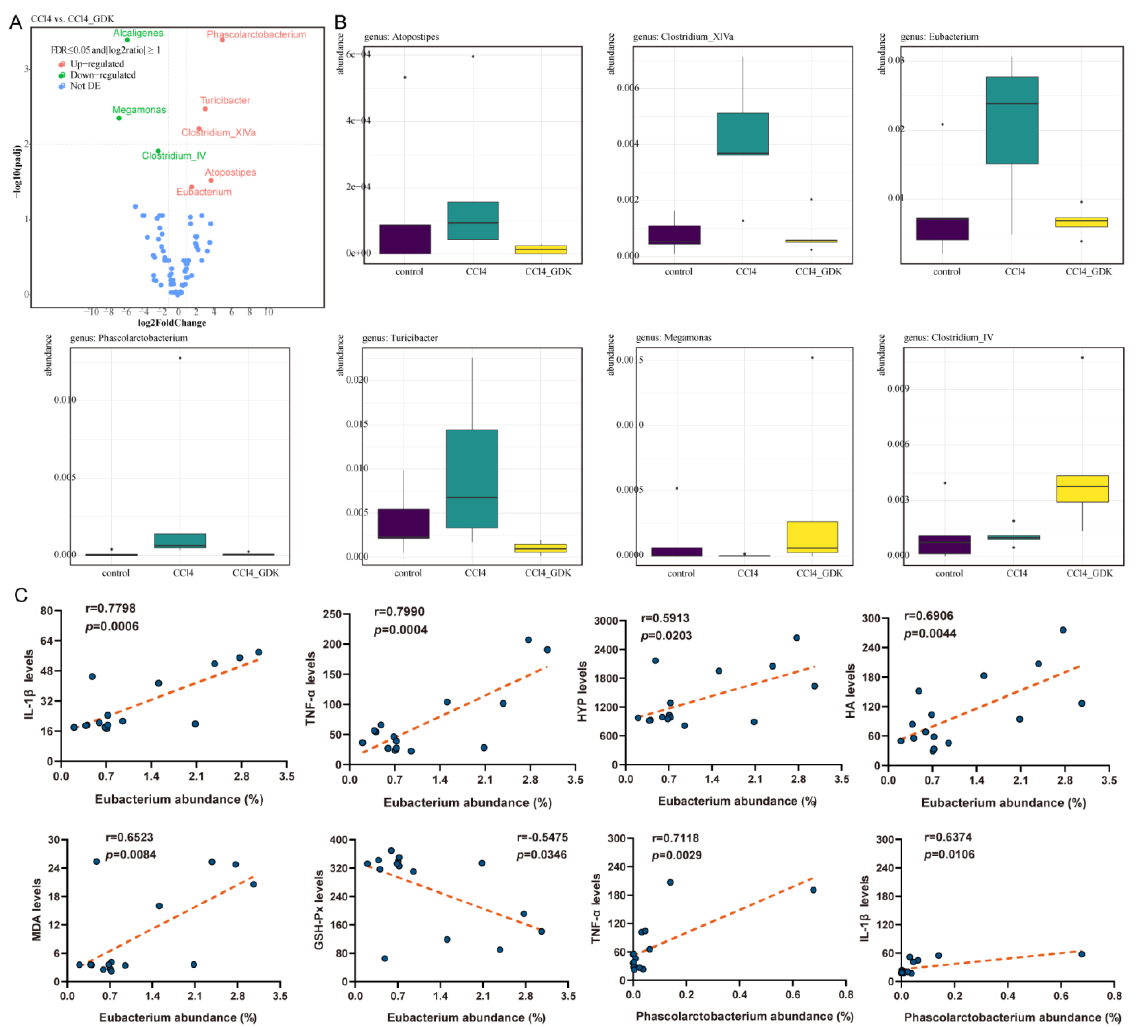
Figure 7. Analysis of the differences in species composition between groups upon GDK treatment. ( A ) Volcanic map of grouping difference in species composition (genus level). ( B ) Differential flora among control, CCl 4 , and GDK groups. ( C ) Correlation analysis of Eubacterium and Phascolarctobac- terium with IL-1 β , TNF- α , HYP, HA, γ GT, MDA, GSH-Px, GST, and GSH levels based on Pearson’s Correlation Coefficient.